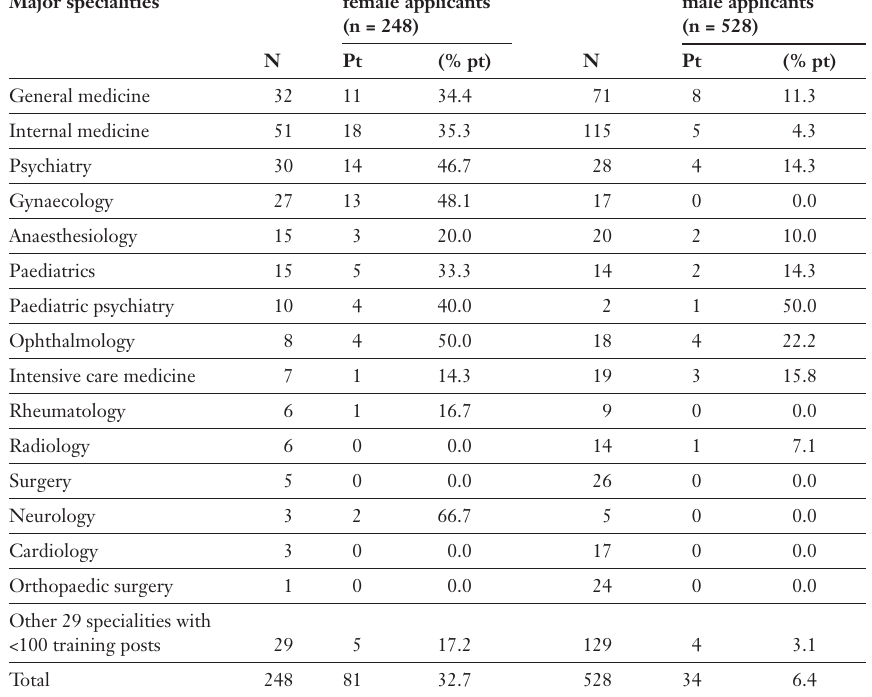
Table 1 Speciality profile and distribution of part-time training experience among the cohort of special- ity diploma appli- cants of the year 2001 Values are num- bers